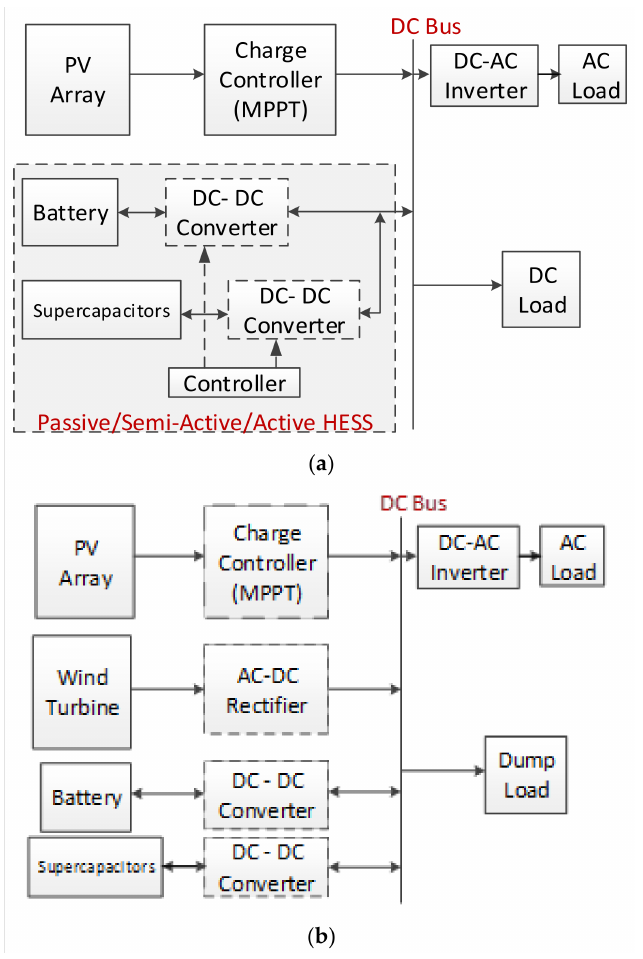
Figure 11. ( a ) A stand-alone active HESS with SC. ( b ) A HESS for a wind-solar fed